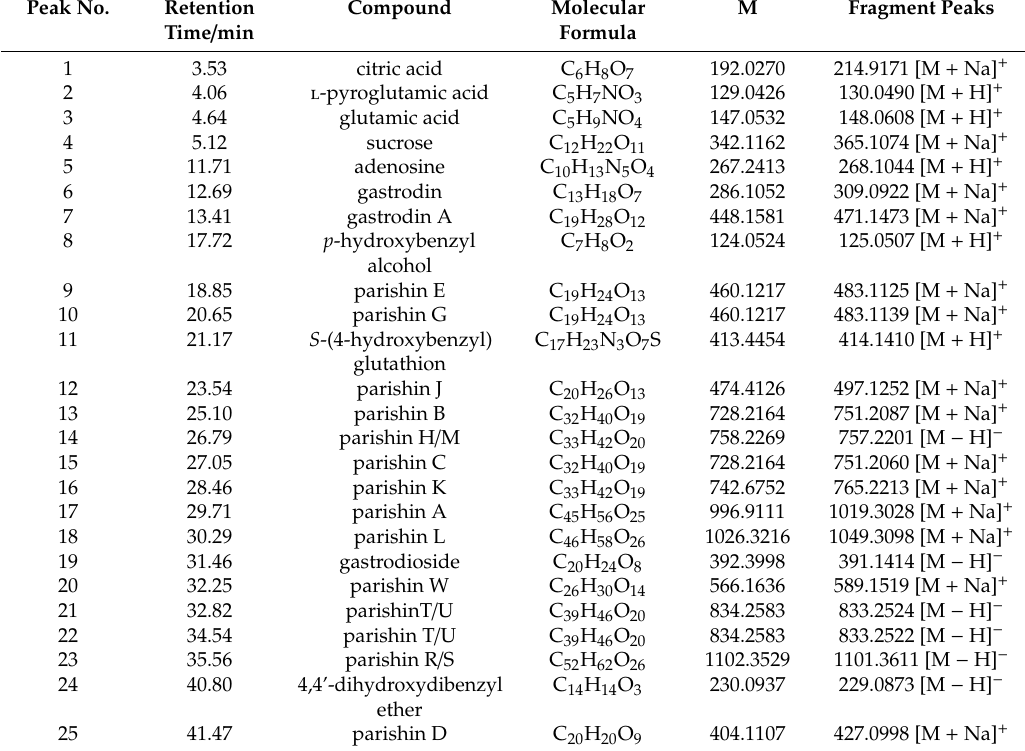
Table 1. ESI-TOF / MS accurate mass measurements of 25 compounds of RGE. Peak